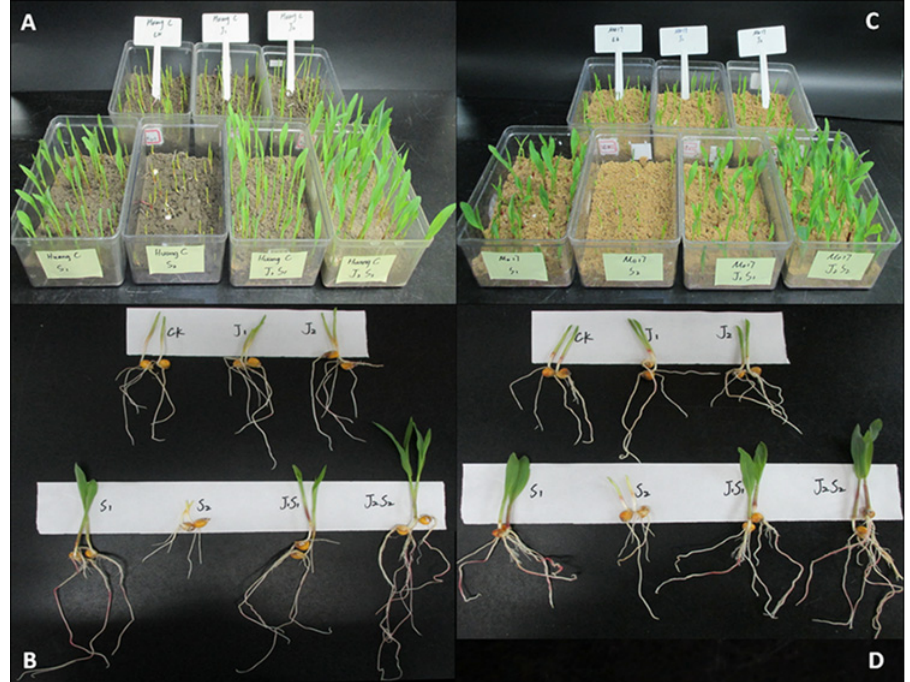
Fig 7. Effect of agent on seedling growth of maize varieties Huang C (HC) and Mo17 after chilling stress. ( A and B are Huang C; C and D are Mo17. The seedlings grew for 11 days including 5-day germination and growth at 25°C, 3-day chilling stress at 5°C and 3-day recover growth at 25°C. Ck . Control: maize seeds coated with formula 0; J1 . maize seeds coated with formula 1; J2 . maize seeds coated with formula 2; S1 . maize seeds coated with formula 3; S2 . maize seeds coated with formula 4; J1S1 . maize seeds coated with formula 5; J2S2 . maize seeds coated with formula 6. The coating agents were applied at a rate of 1 g per 5 g naked seeds for all of the treatments. For the different formulas, see the explanations in Table